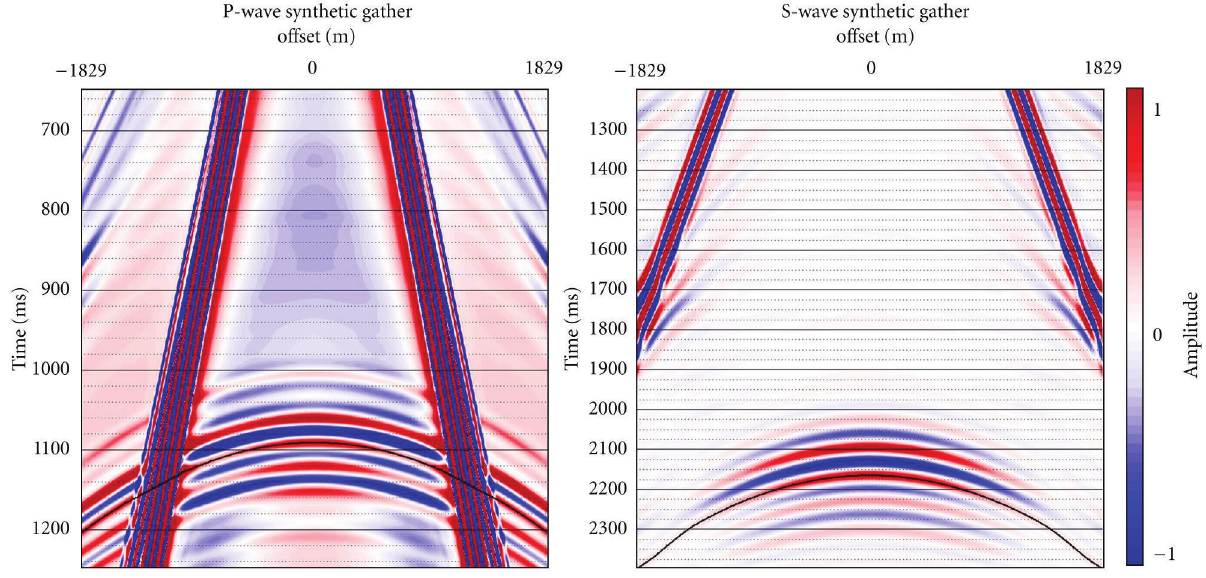
Figure 18: Full waveform synthetic gathers for P-wave (left) and S-wave (right) reflectivity. The Morrow A sandstone top is indicated by the black curve.